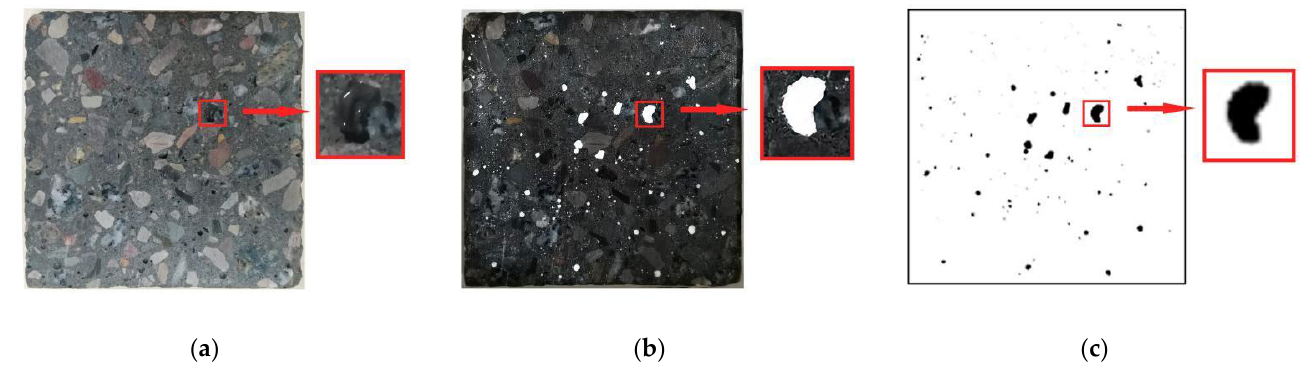
Figure 4. Pore flow chart of binarization processing test block. ( a ) Untreated test blocks; ( b ) test block after grinding; ( c ) completed test blocks.